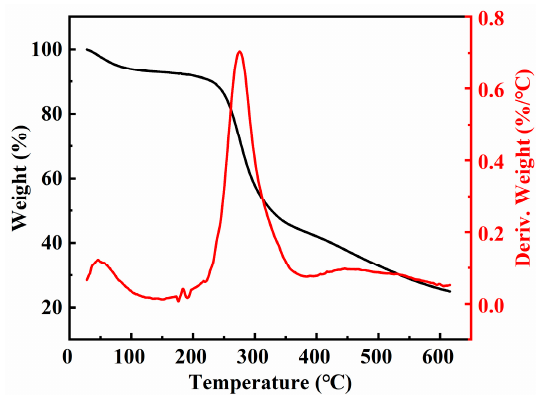
Table 4 and Figure S4. Two endothermic peaks appeared in the IC-FWBP during heating. The peak temperatures for IC-FWBP were 88.06 ◦ C and 206.79 ◦ C, respectively.